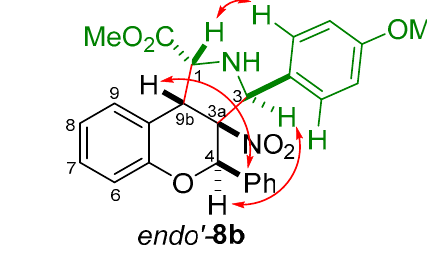
atoms. The cross-peak H-9b ↔ H-3 is not observed in the spectra of both isomers.